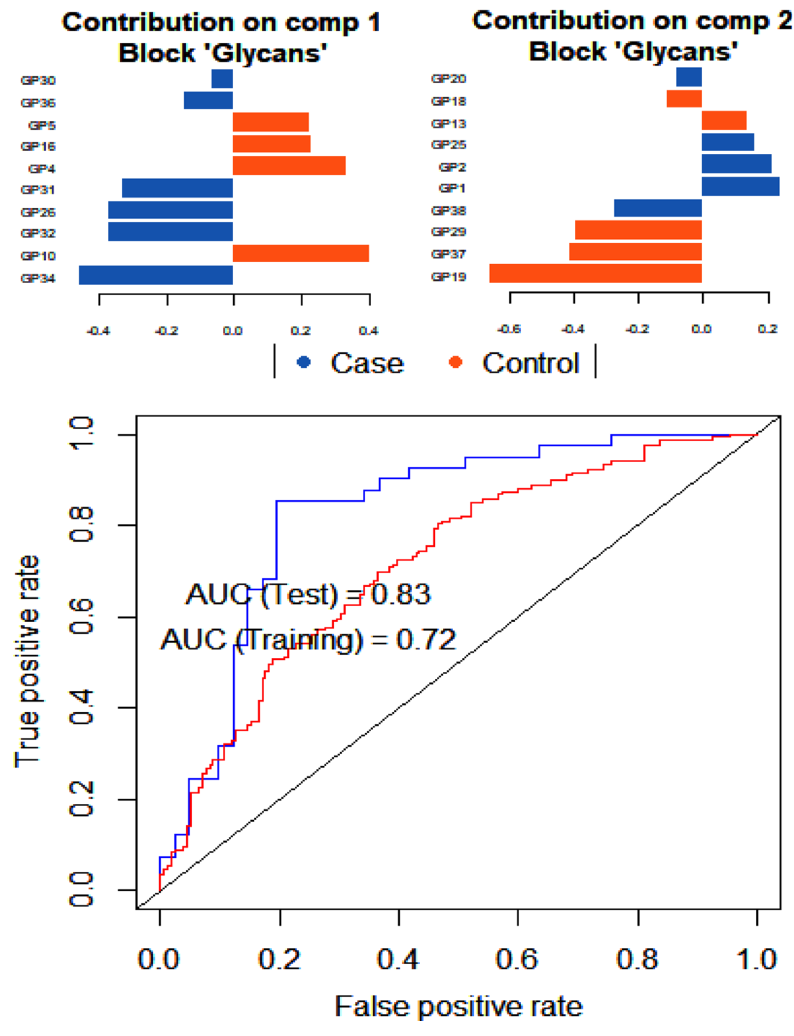
Figure 4. Principal component and discrimination analysis of top expressive glycans in T2DM and healthy controls. Feature selections are important in the refinement of biological and biochemical hypotheses. We identified a combination of discriminative features from a disparate block of N-glycan data set. N-glycan peaks loaded differently along the two principal components (PC), with estimates of positive and negative weights. A large absolute value indicates the importance of the variable to the PC and the colour codes indicate how prominent the biomarker expressed in T2DM and healthy controls. Selected variables were ranked from the least important to the most important. The classification accuracy the training and testing of the discriminant function formulated using the 10 glycans associated with component 1 reveals a model with good learning